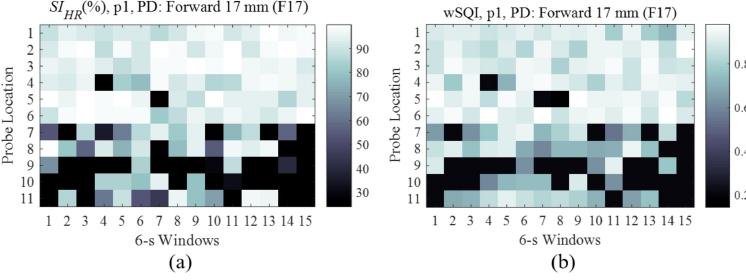
Figure 5. Indices according to probe locations in p1 and a 6-s windows: ( a ) SI HR and ( b ) wSQI.